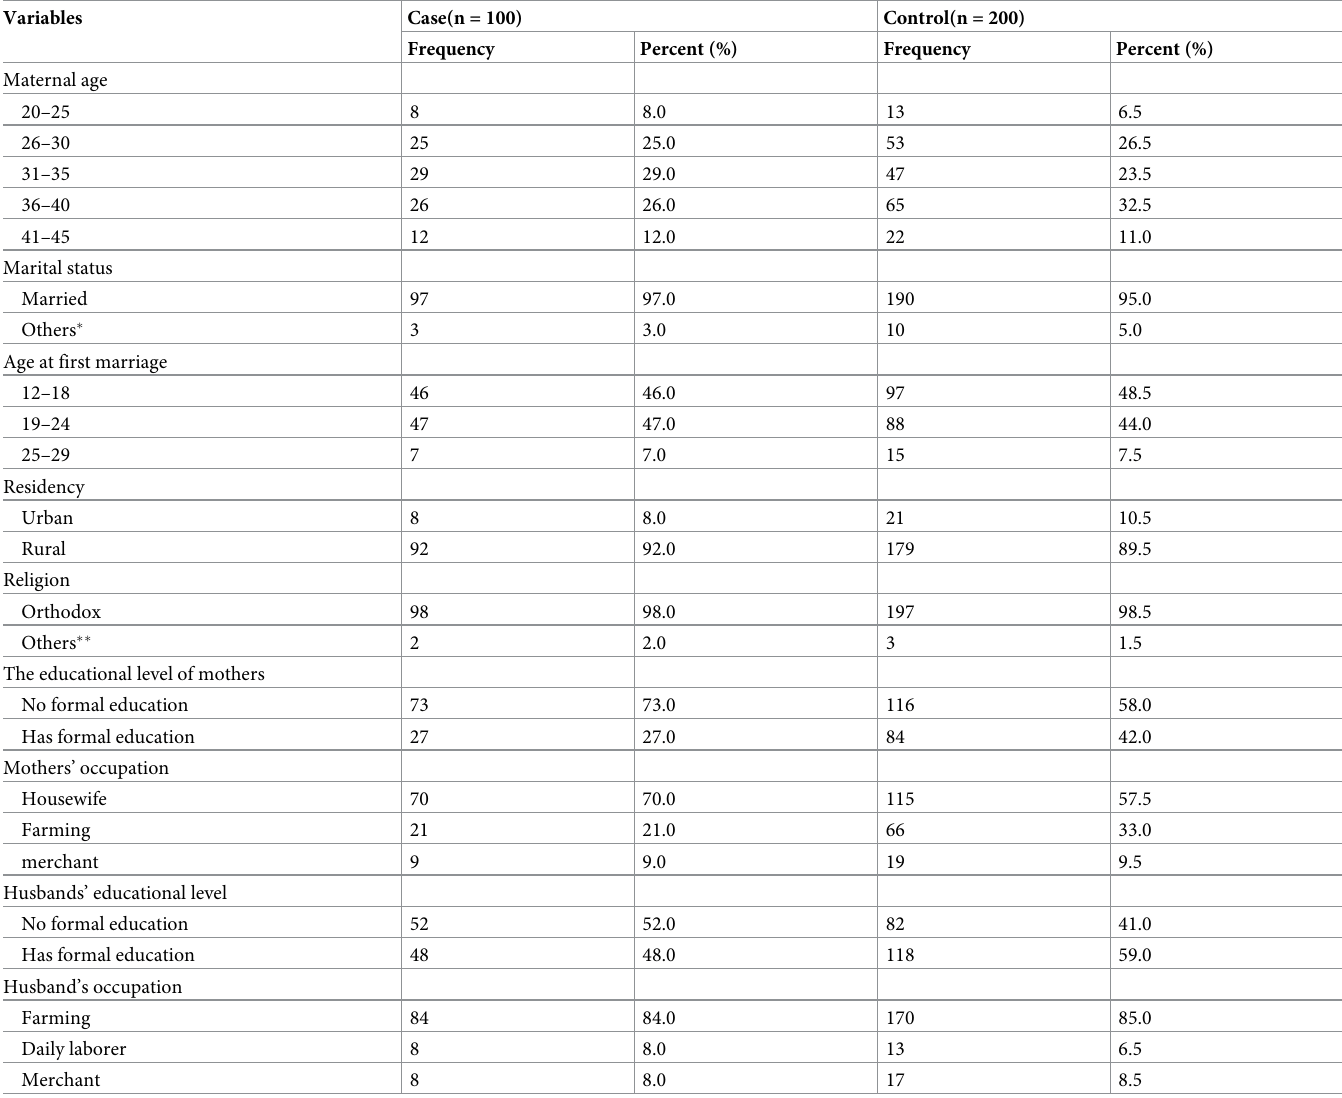
Table 1. Socio-demographic characteristics of reproductive age mothers (N = 300) in Farta Woreda, South Gondar Zone, North West, Ethiopia,